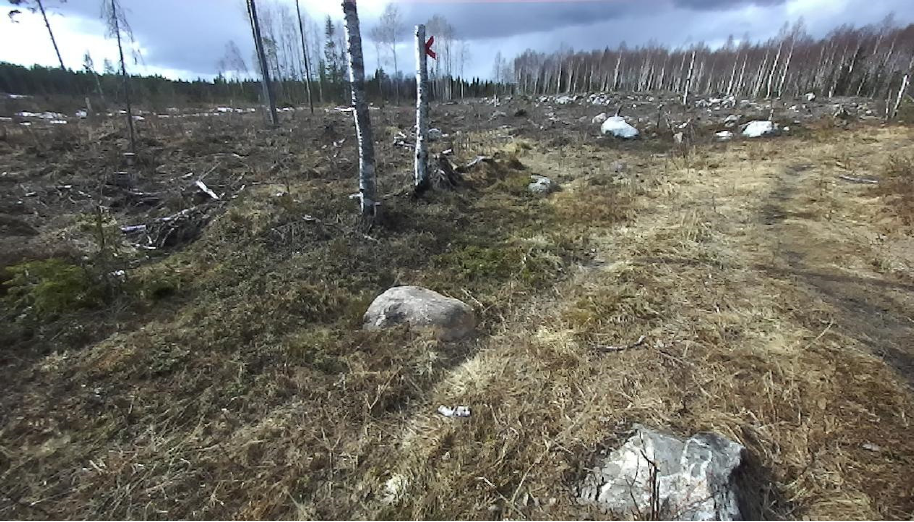
Figure 1. The field for data collection.